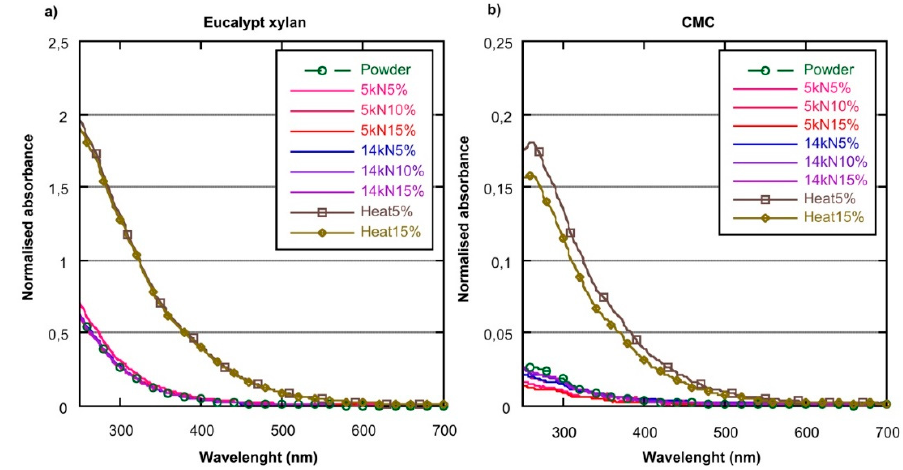
Figure 9. Test results from the spectrophotometer where ( a ) are xylan pellets and ( b ) CMC pellets.